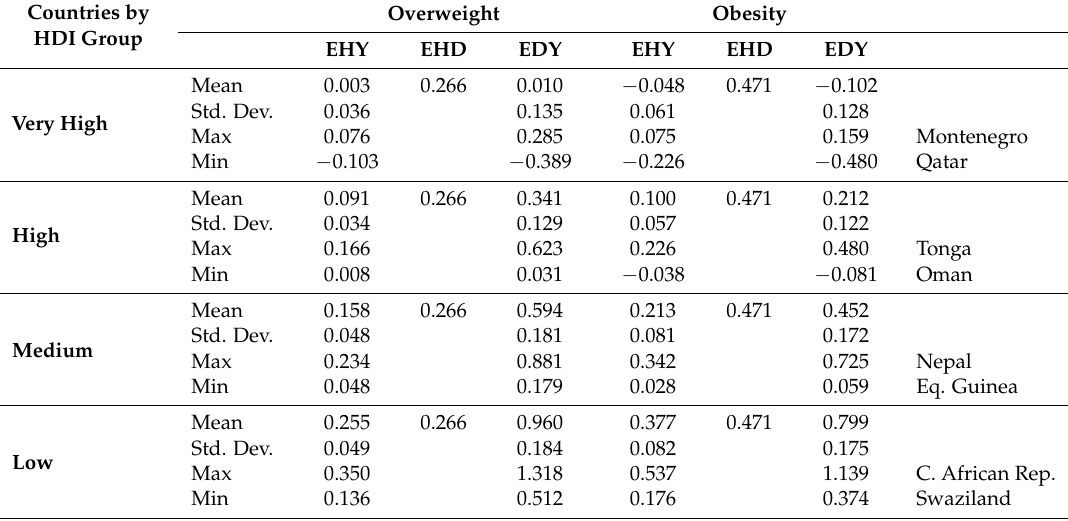
Table 5. Output and Income Elasticities.